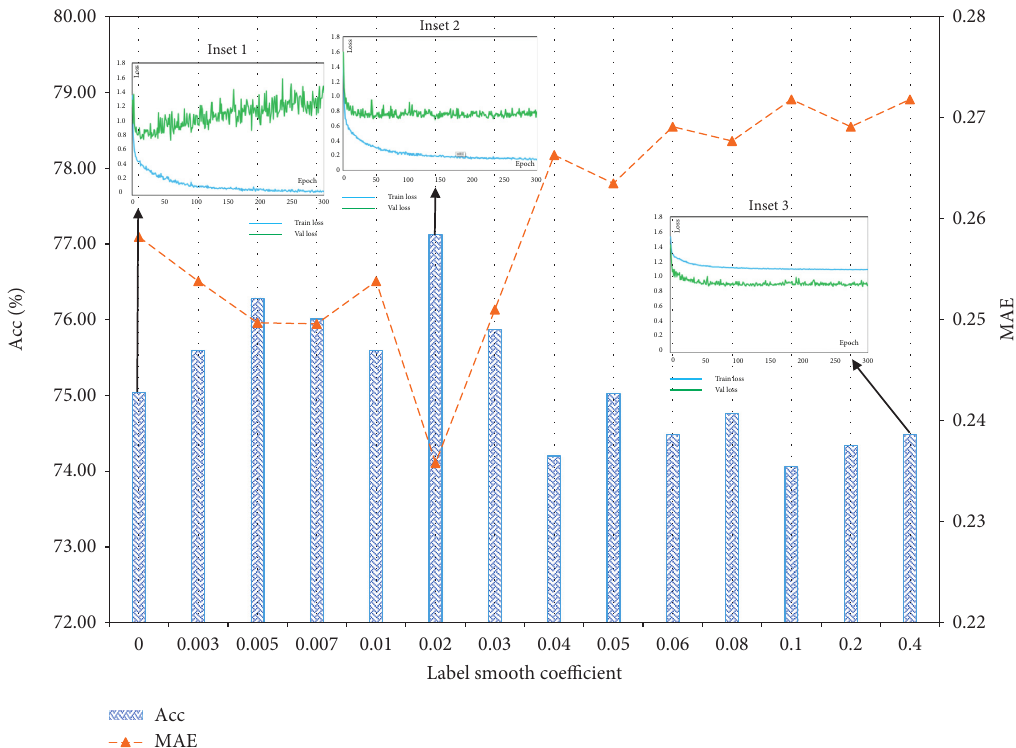
Figure 10: Performance and convergence of SOCNN based on different label smoothing